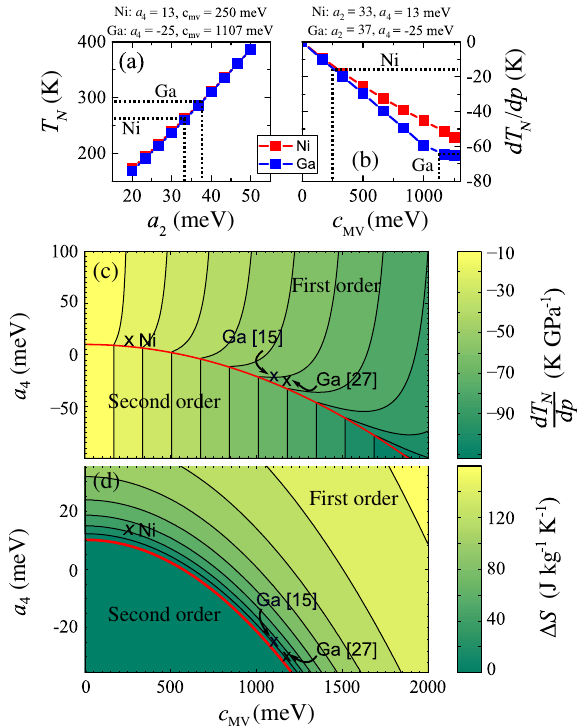
= ð dp Þ(cid:2) FIG. 4. The theoretical quantities (a) T and (b) ½ð dT N N Þ as a function of a 2 and c , respectively, calculated using our MV model described in the text. Dotted lines indicate the exper- imentally measured values for A ¼ Ni and Ga. The parameters used are shown above each plot. (c),(d) The dependence of = ð dp Þ(cid:2) and (d) Δ S as a function of a 4 and c (c) ½ð dT with N Þ MV a 2 ¼ 36 meV for both nitride systems. The plot is effectively insensitive to the a 2 value for the pertinent range ( 33 < a 2 < 37 meV). The red line indicates the critical curve separating first- and second-order